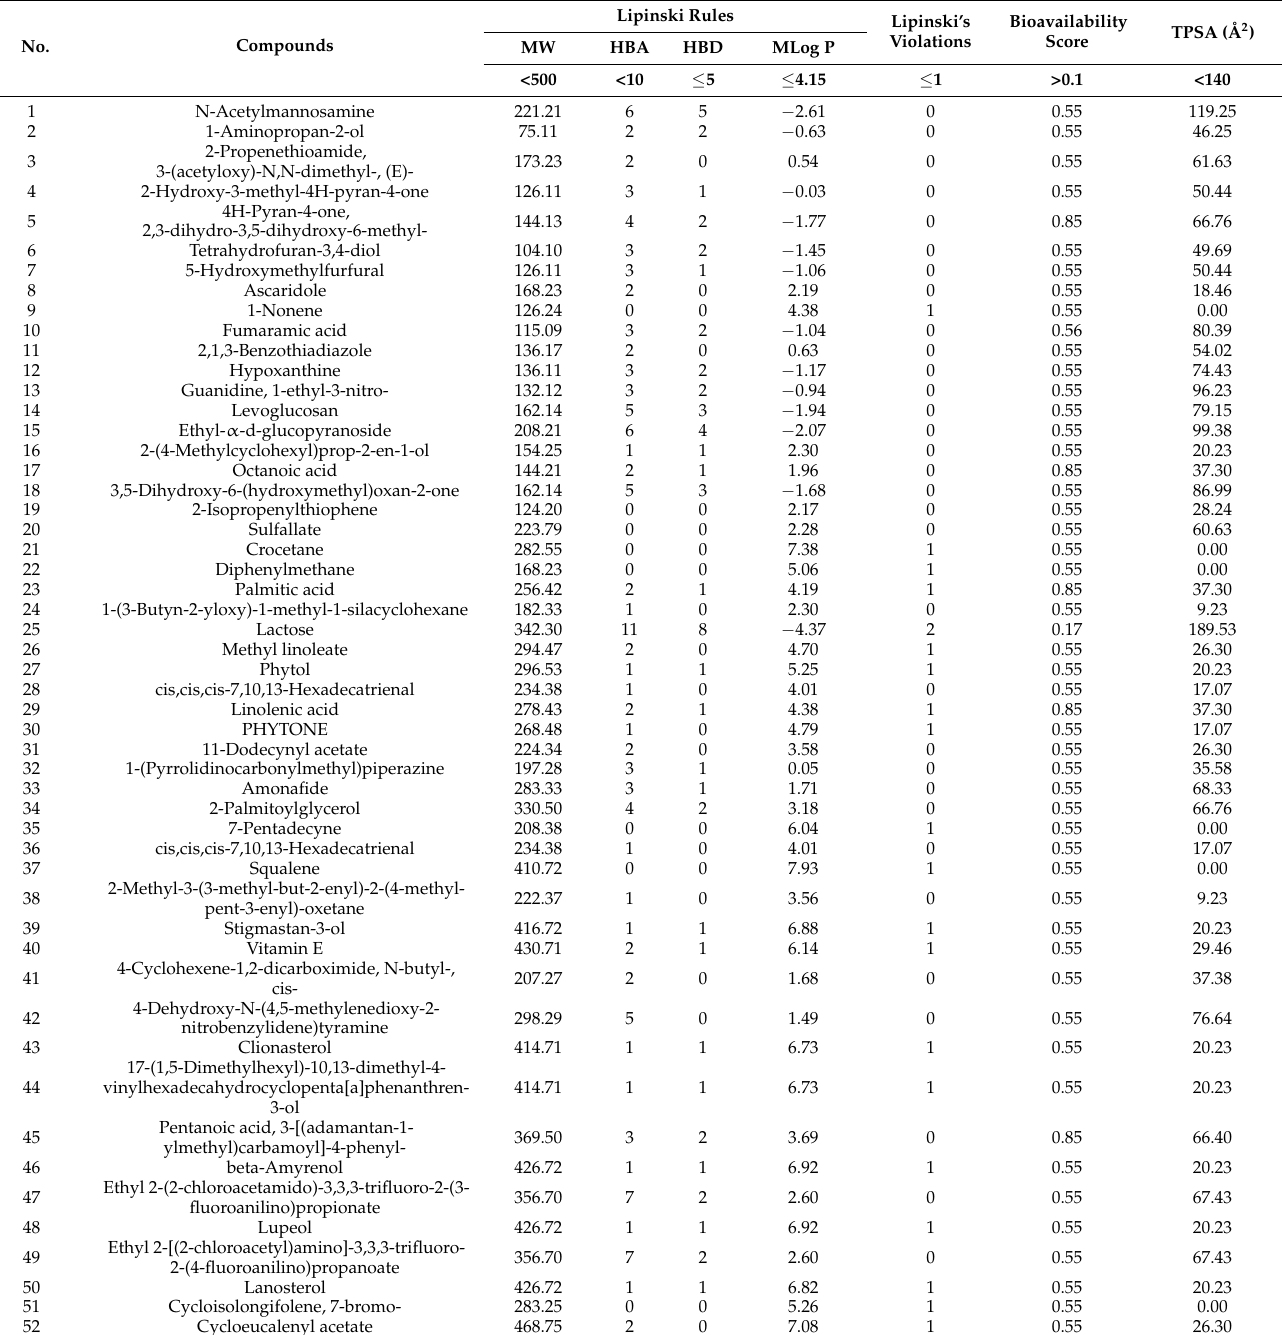
Table 2. Physicochemical properties of chemical compounds for good oral bioavailability and cell membrane permeability.